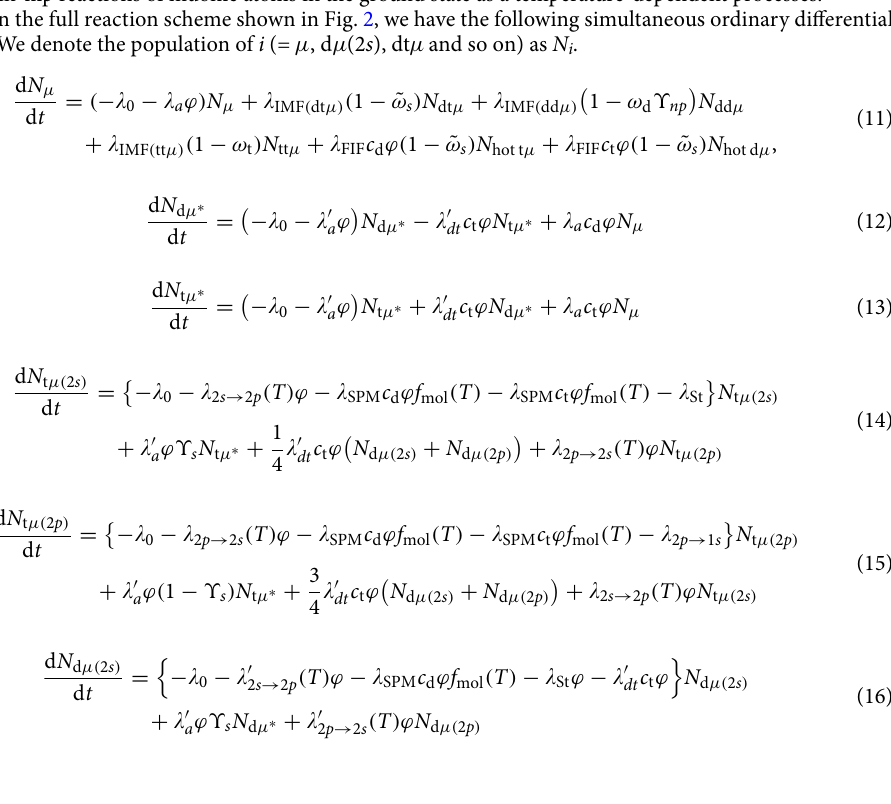
3 ; AC-2 assumes T i = 300 K and ϕ i = 10 − 2 ; SWC-3 assumes 300 K and initial ϕ i = 10 −